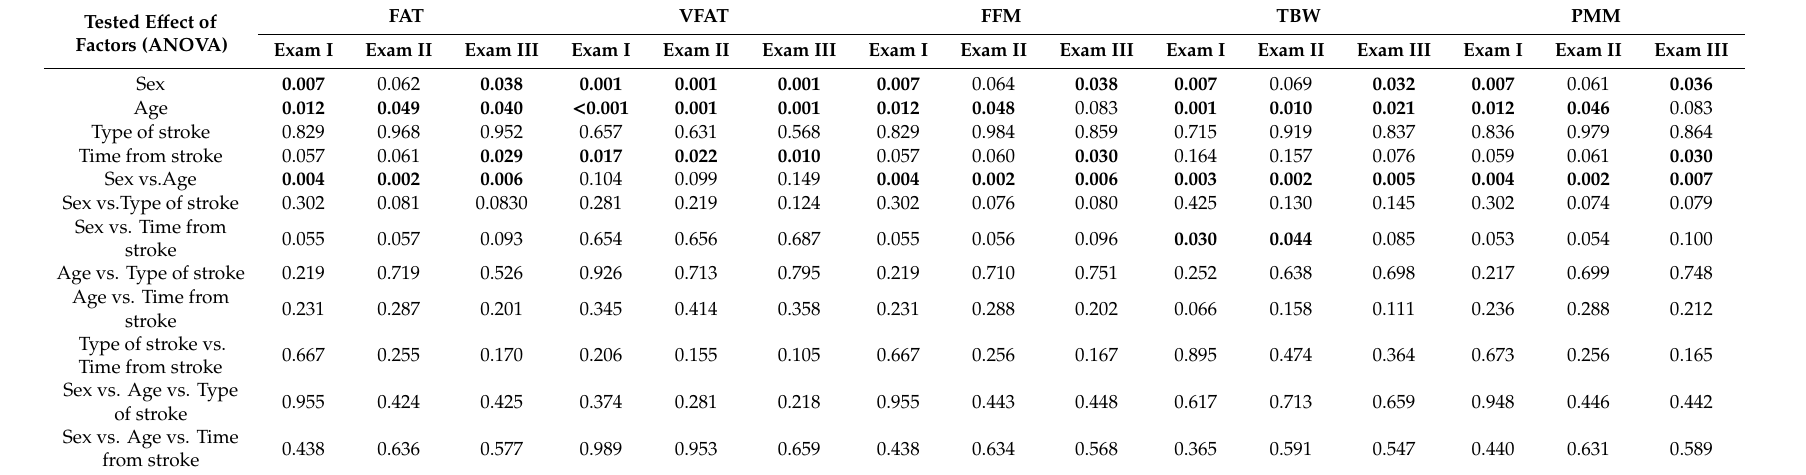
FAT: body fat; VFAT: visceral fat; FFM: fat-free mass; TBW: total body water; PMM muscle mass; bold value: statistical